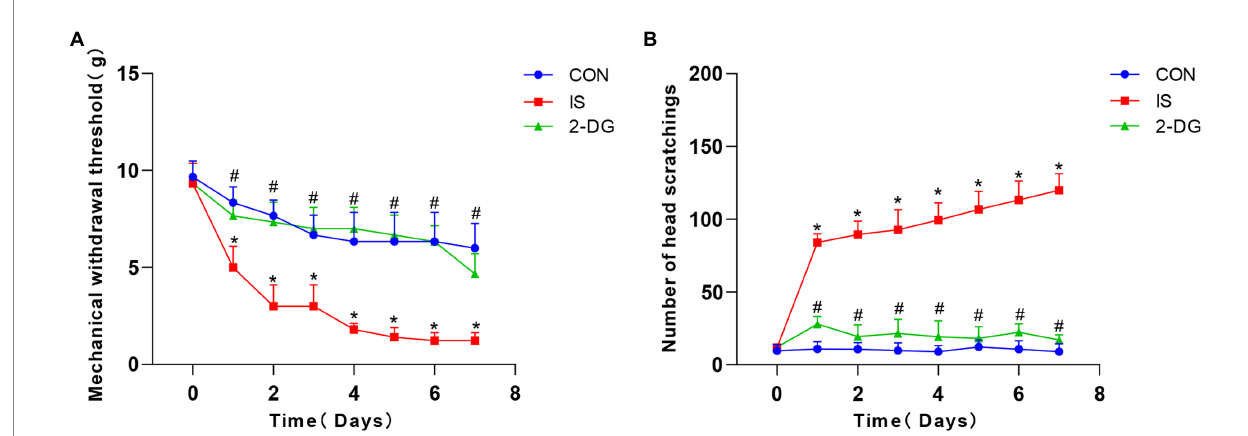
FIGURE 2 2-DG alleviated nociceptive behavior induced by repeated IS dural infusion. (A) The pain threshold of IS group decreased with the days of administration and was lower than that of the CON group, and 2-DG alleviated the IS-induced decrease in pain threshold. Data were expressed as mean ± SD ( n = 6 per group). *represent IS versus control; #represent 2-DG versus IS. * p < 0.05, # p < 0.05. (B) The number of head-scratching in IS group was significantly higher than that of the CON group, and 2-DG alleviated the IS-induced increase in head-scratching frequency. Data were expressed as mean ± SD ( n = 6 per group). *represent IS versus control; #represent 2-DG versus IS. * p < 0.05, # p <